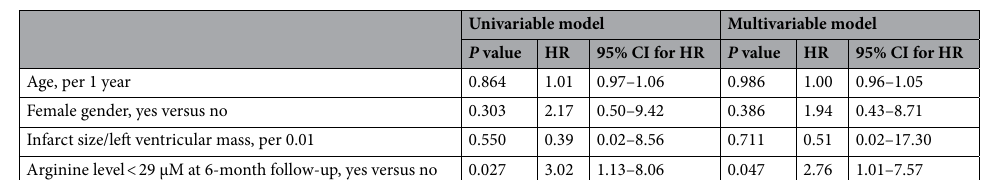
Table 5. The independent predictors of death, recurrent myocardial infarction or hospitalization due to heart failure decompensation. CI confidence interval, HR hazard ratio, NO x